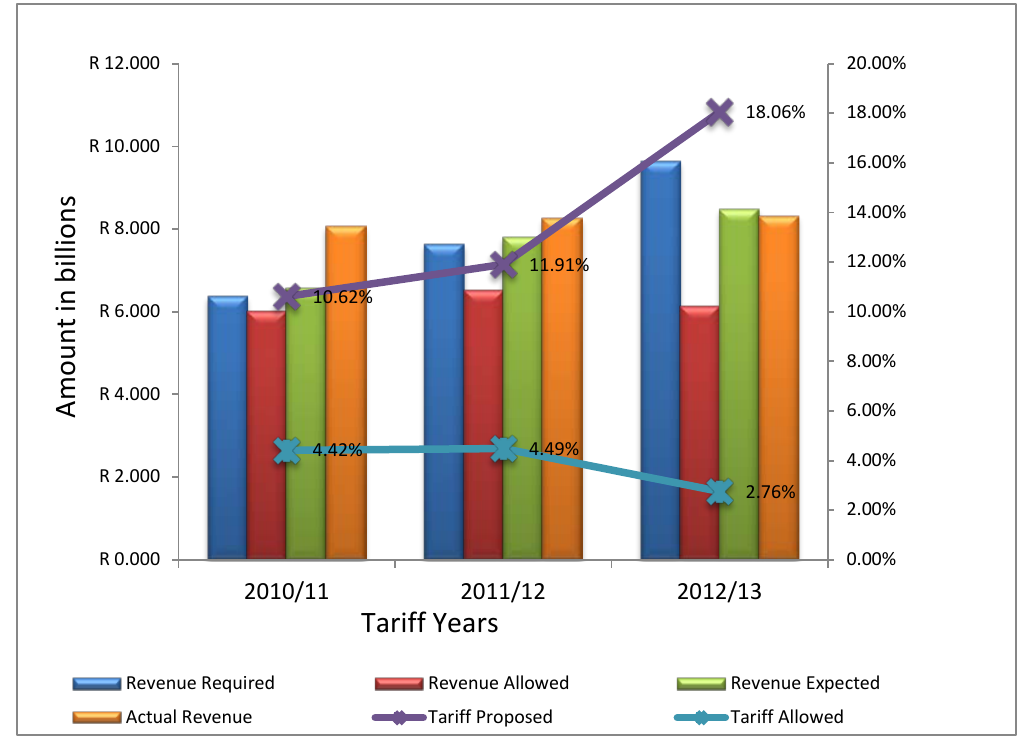
FIGURE 1: Tariff results for 2010/11, 2011/12, and 2012/13 Tariff years